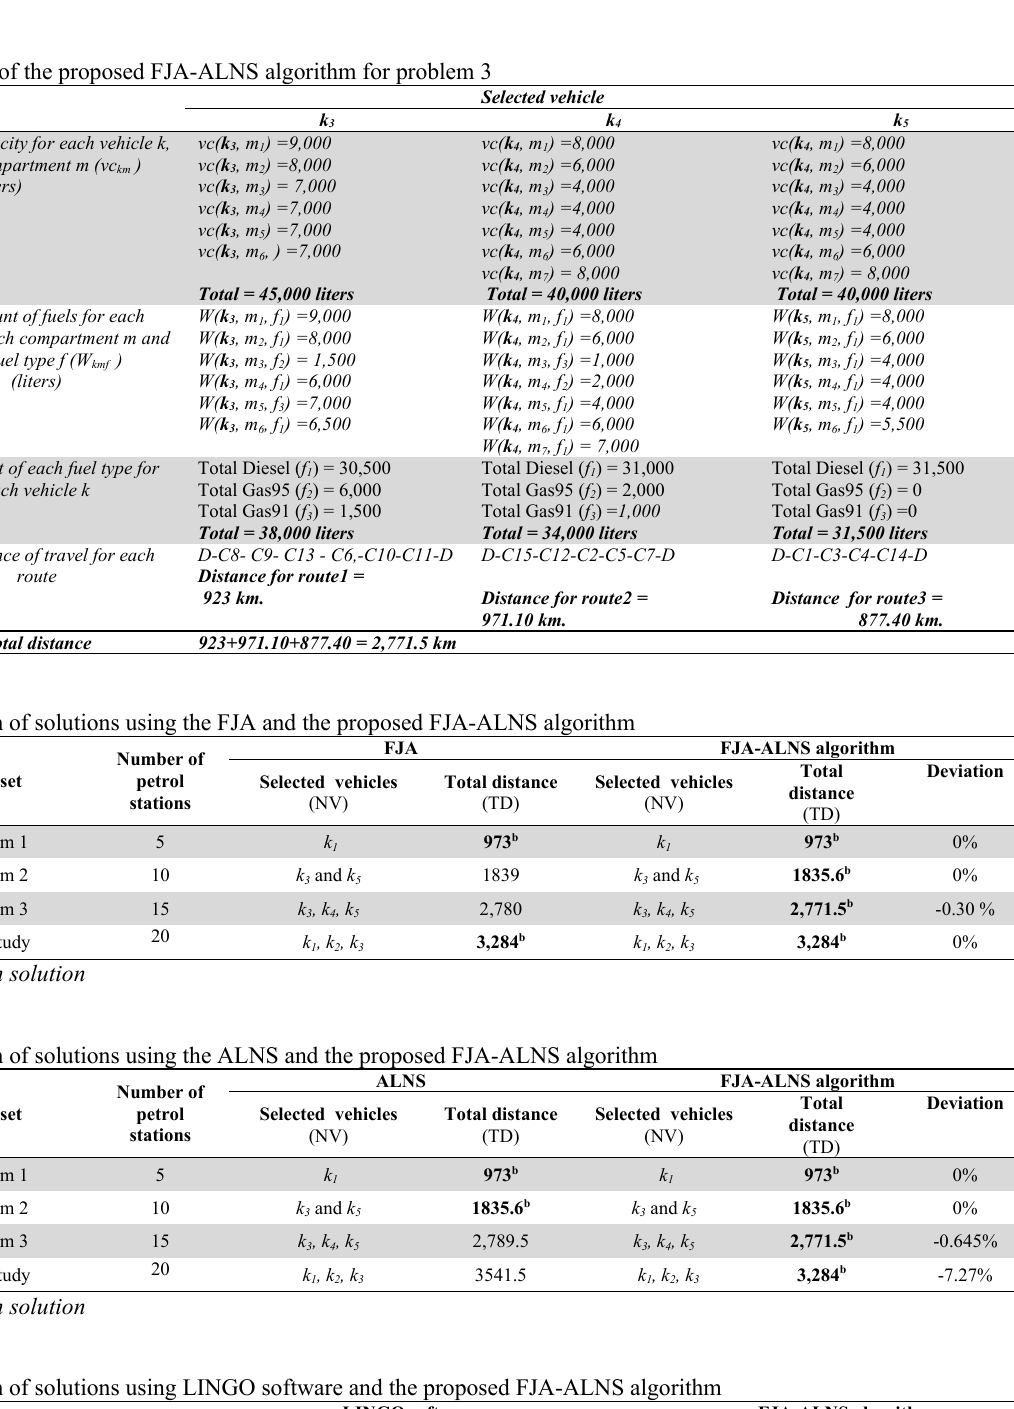
The results of the proposed FJA-ALNS algorithm for problem 3 Results k 3 k 4 k 5 Vehicle capacity for each vehicle k, each compartment m (vc km ) (liters)